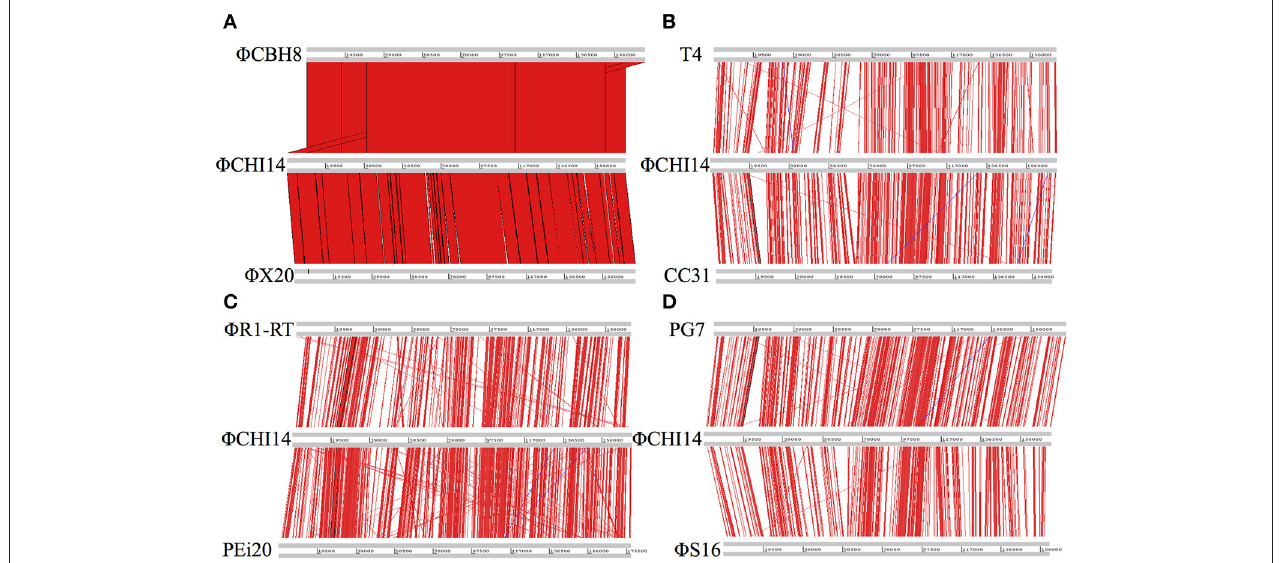
FIGURE 2 | Whole genome alignment of wild type 8 CHI14 with other T4-like phages. DNA homologies are displayed in red. The degree of similarity is proportional to the intensity of red. Similar linear organization of the genome is observed between the aligned phages: (A) Comparison with 8 CBH8 and 8 X20. (B) Comparison with T4 and CC31. (C) Comparison with phage 8 R1-RT and PEi20. (D) Comparison with PG7 and 8 S16.